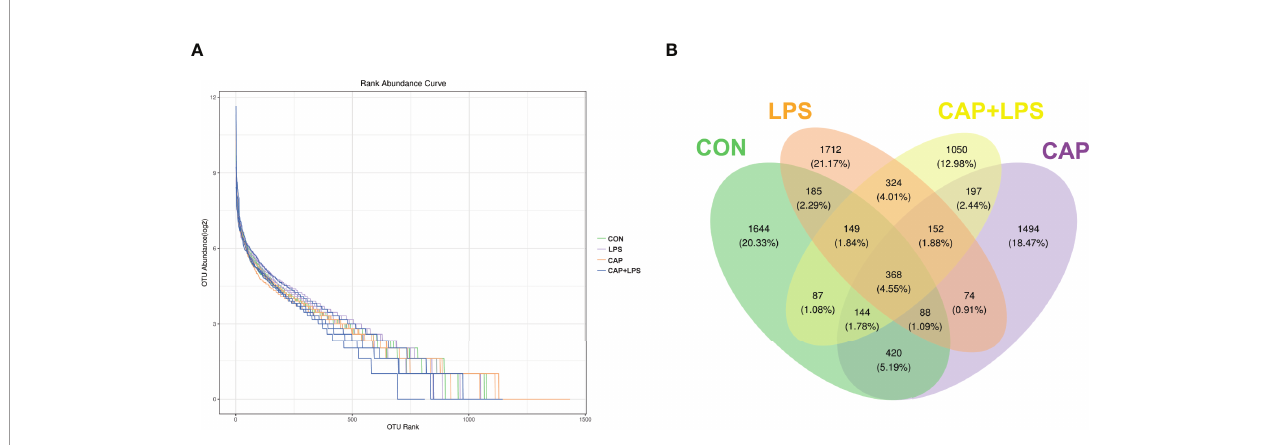
FIGURE 6 | (A) Rank abundance curves in each sample (n = 4); (B) Venn diagram depicting richness and overlap of OTU in four groups (n